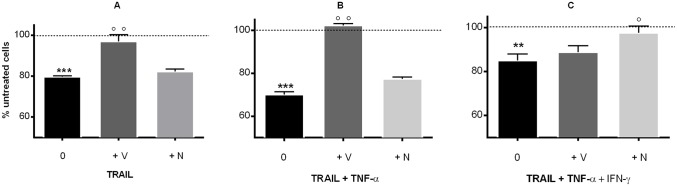
Mechanisms involved in cell death.hUC-MSCs of clone 63 (2x104 in 96-well plates) were pretreated for 2h with zVAD-fmk (V, 20 μM) or necrostatin-1 (N, 50 μM) then stimulated with TRAIL (500 ng/ml, 28 nM) alone or in association with TNF-α (20 ng/ml, 1.2 nM) and IFN-γ (50 ng/ml, 3 nM) for 24h. Then, cell death was scored by CellTiter-Glo Luminescent Cell Viability Assay. Data are presented as mean±SEM of three ATP measurements; *** p<0.0001, **p<0.01 when compared with untreated cells; °p<0.05, °°p<0.01 when compared with TRAIL-treated, TRAIL-associated with TNF-α or TNF-α associated with IFN-γ-treated cells). Representative of 2 different experiments using alternatively hUC-MSCs clone 63 and 69 with the same results.